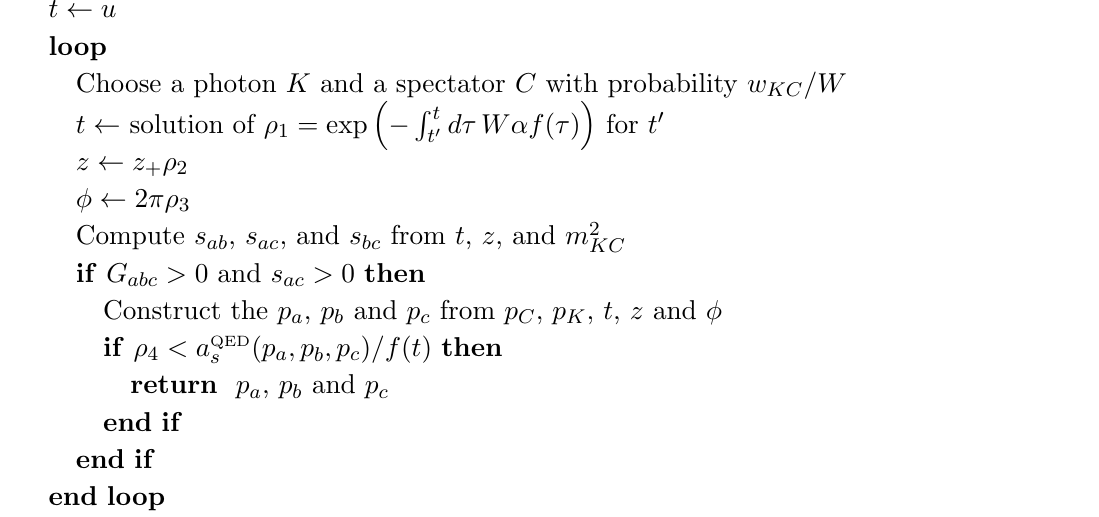
Algorithm 3 The Sudakov veto algorithm for photon